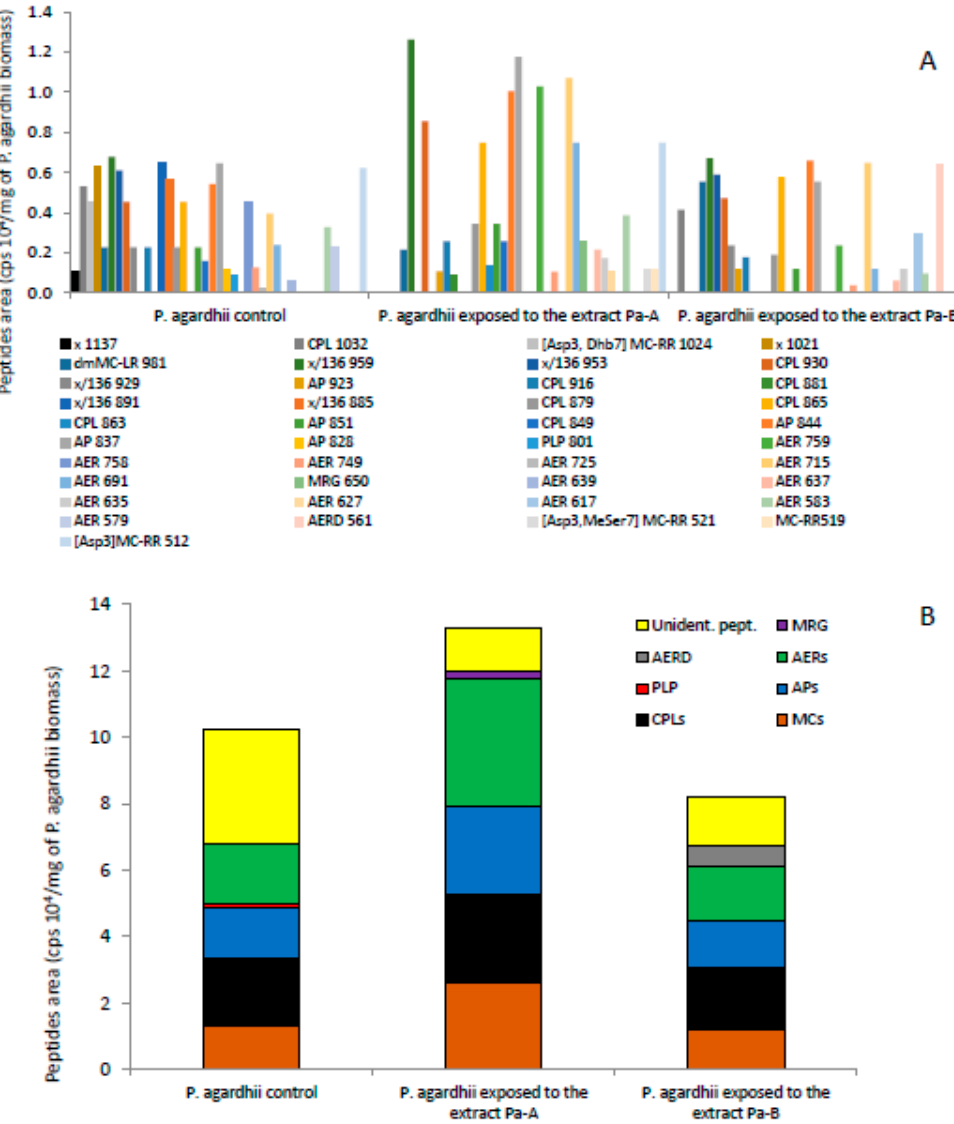
Figure 5. Relative content of particular oligopeptides ( A ) and oligopeptides groups ( B ) in P. agardhii exposed to the extracts obtained from two P. agardhi -dominated scum samples.